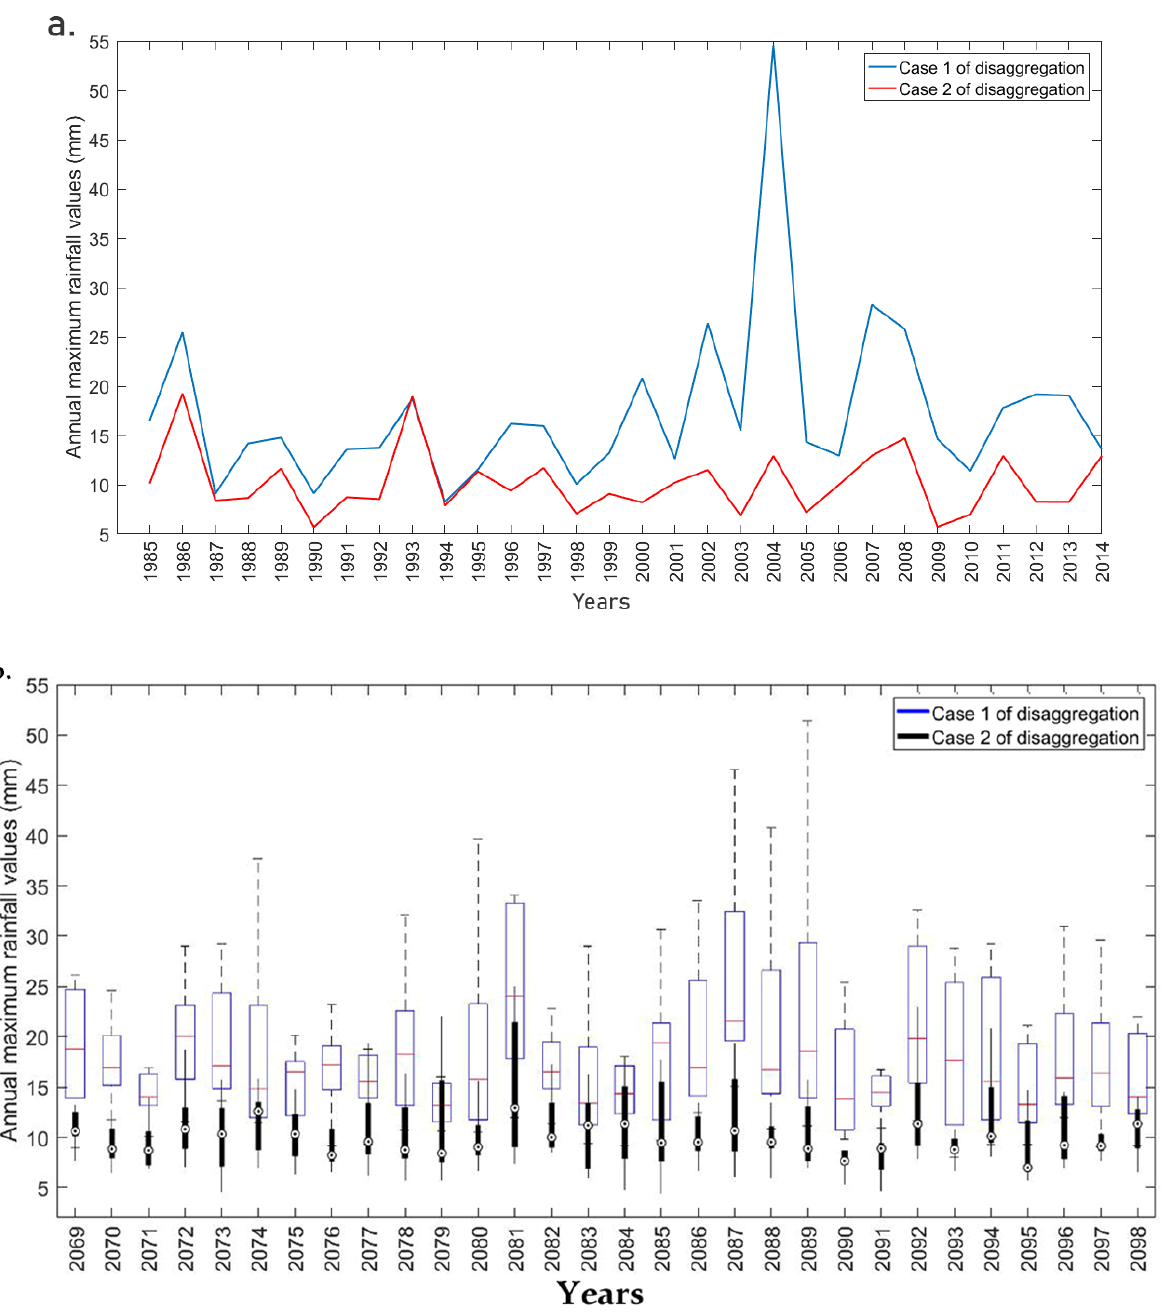
Figure 2. Annual maximum rainfall values produced by the 2 cases of rainfall disaggregation, for the current climate ( a ), and the future climate ( b ).